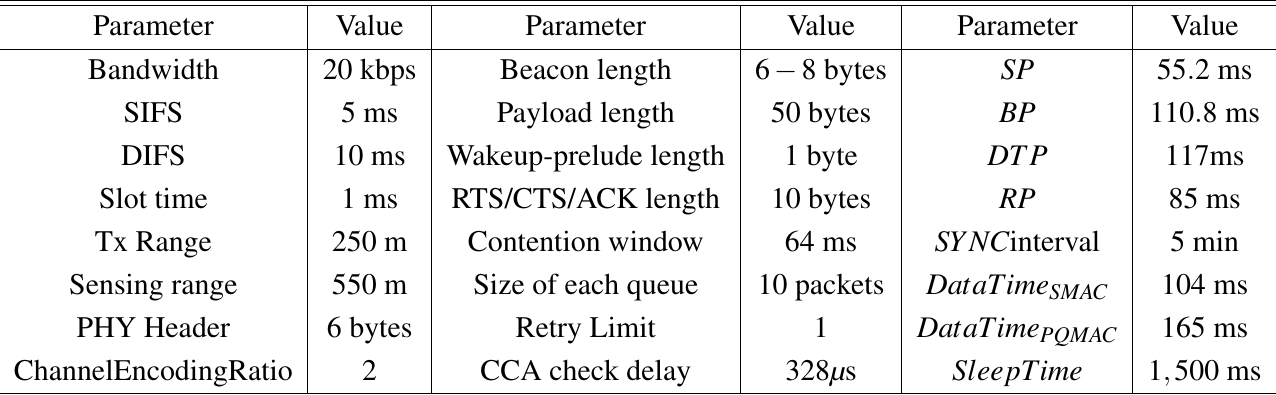
Table 4. Parameters and their values used in the